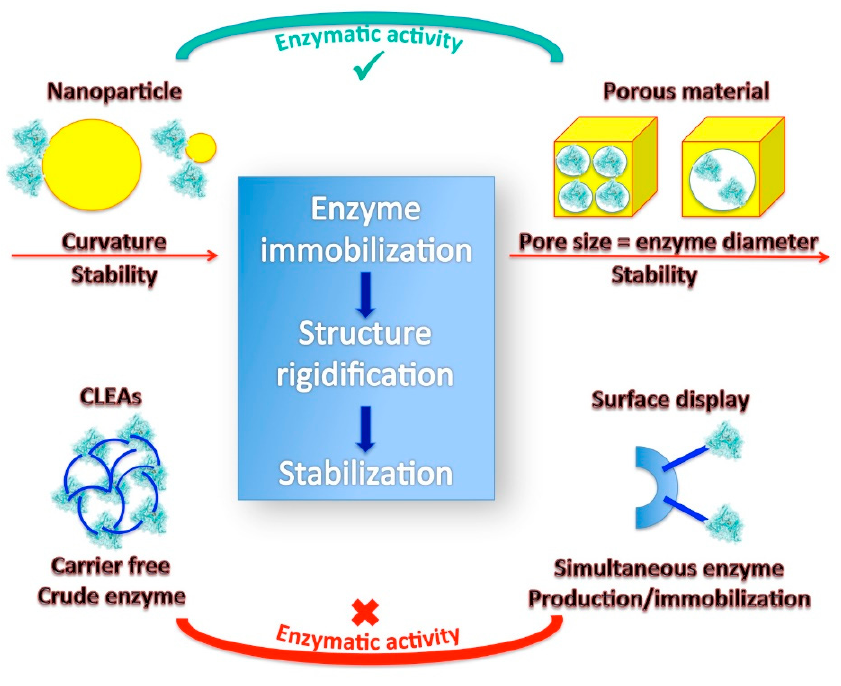
Figure 8. Strategies for enzyme stabilization in the immobilized